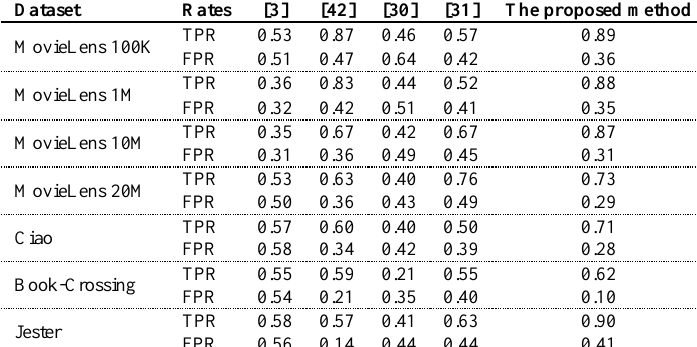
Table 4. Comparison of true positive and false positive rates.